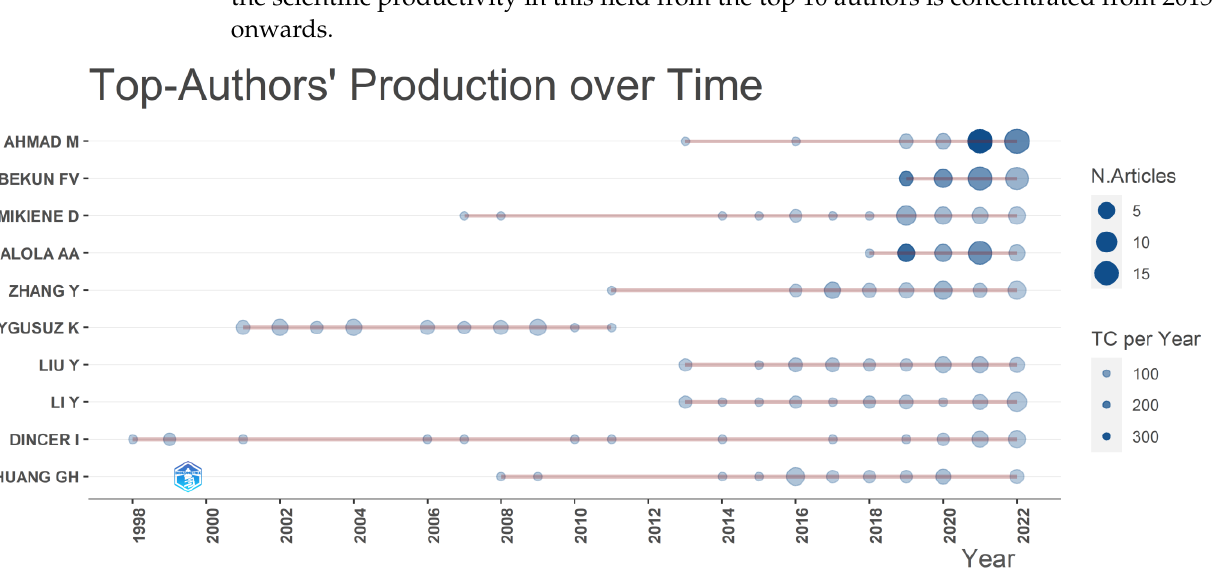
Figure 5. Top 10 authors ’ production over time.